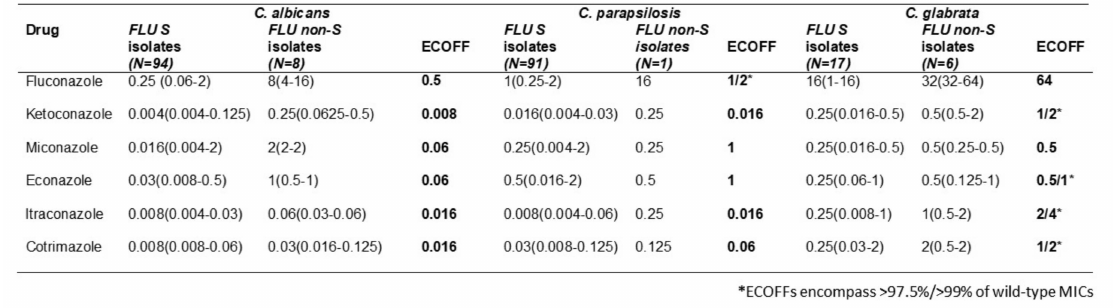
Figure 1. The median (range) MICs for each azole and Candida species for fluconazole susceptible (FLU S) and no- susceptible (FLU non-S) isolates together with estimated local epidemiological cut-off values